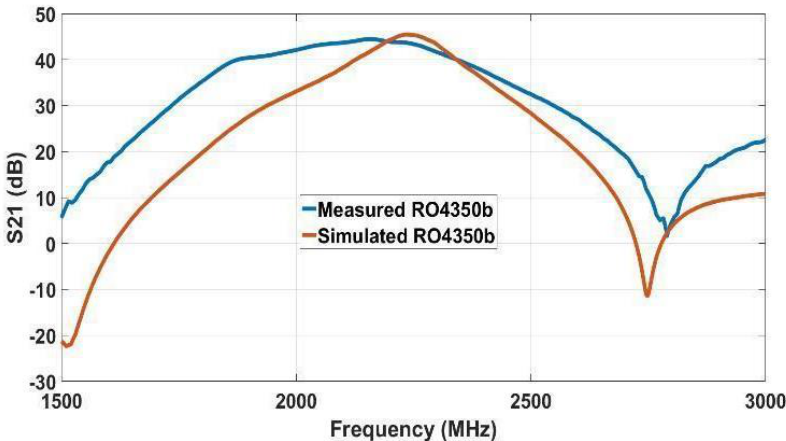
Figure 11. Small-signal transmission characteristics of the simulated and measured results for a RO4350B substrate centered at 2.25 GHz.